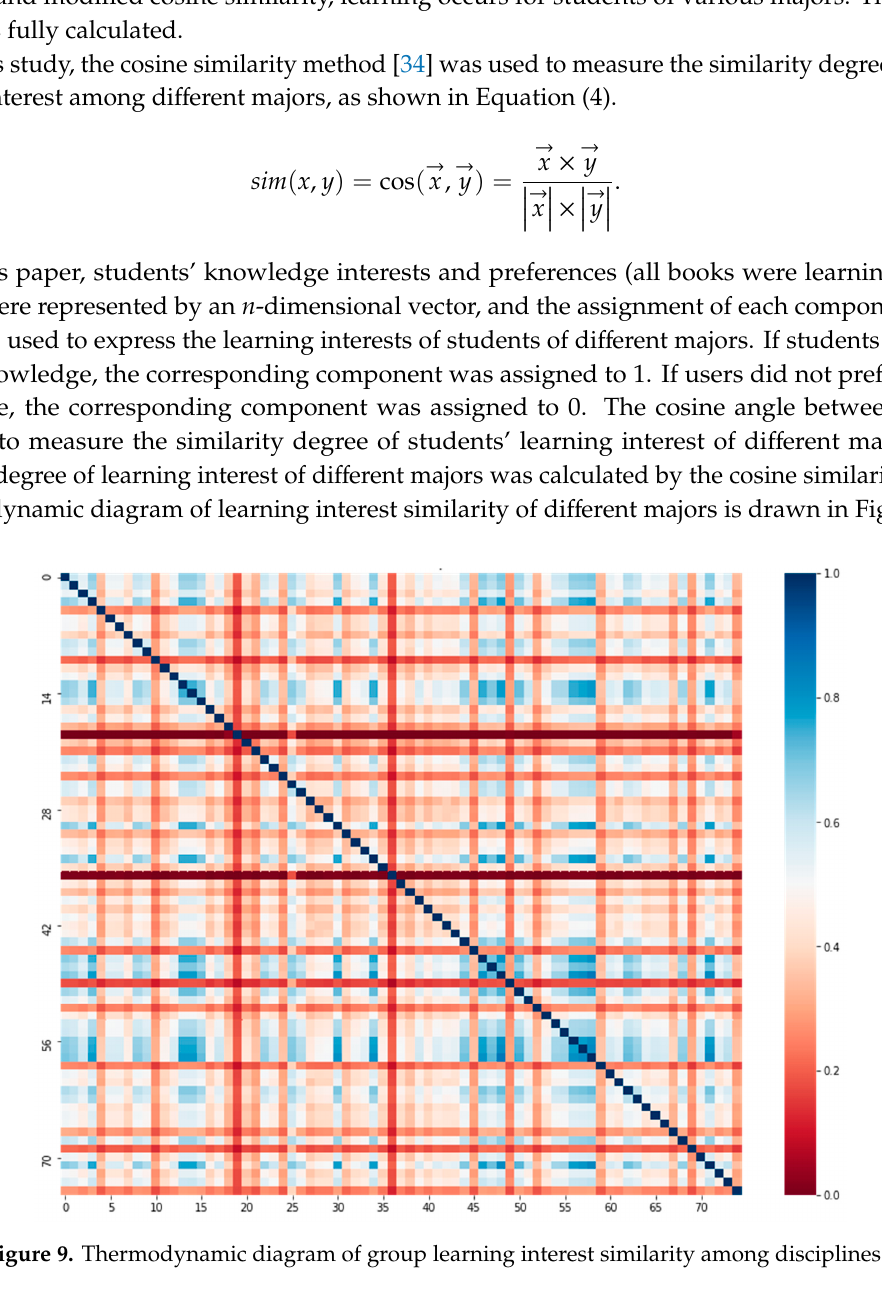
Table 7. Table of serial numbers of each discipline in the thermodynamic diagram.